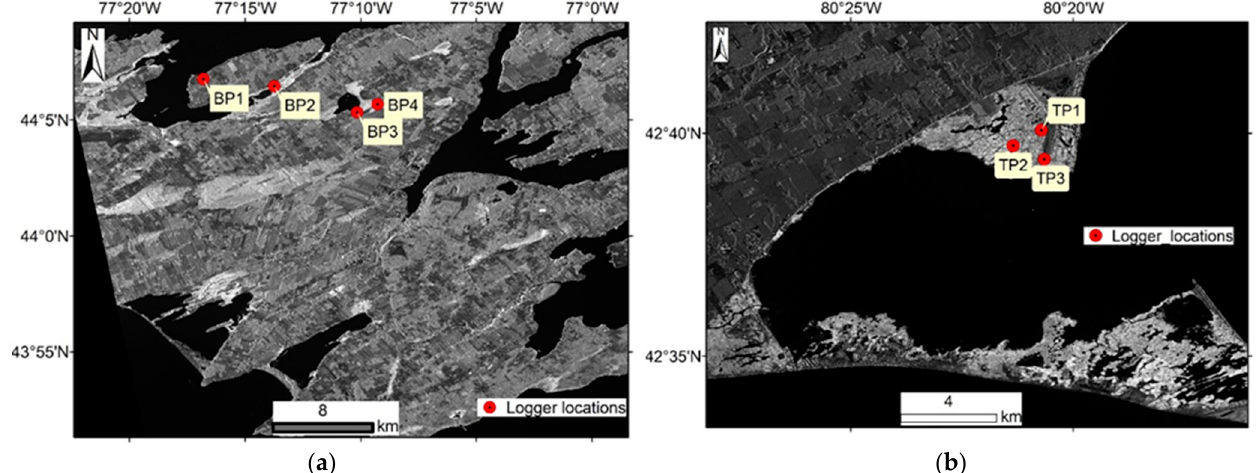
Figure 17. ( a ) Bay of Quinte study area and four water level logger locations and ( b ) Long Point study area with three water level loggers.